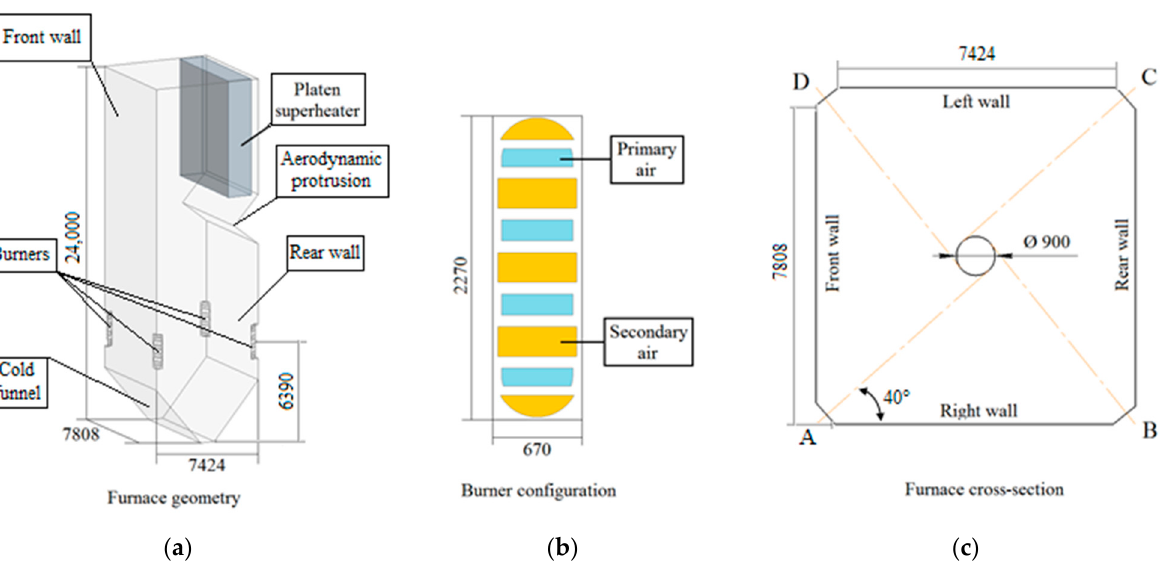
Figure 1. Scheme of the steam boiler furnace BKZ-210-140F ( a ), burner configuration ( b ), furnace cross-section ( c ).